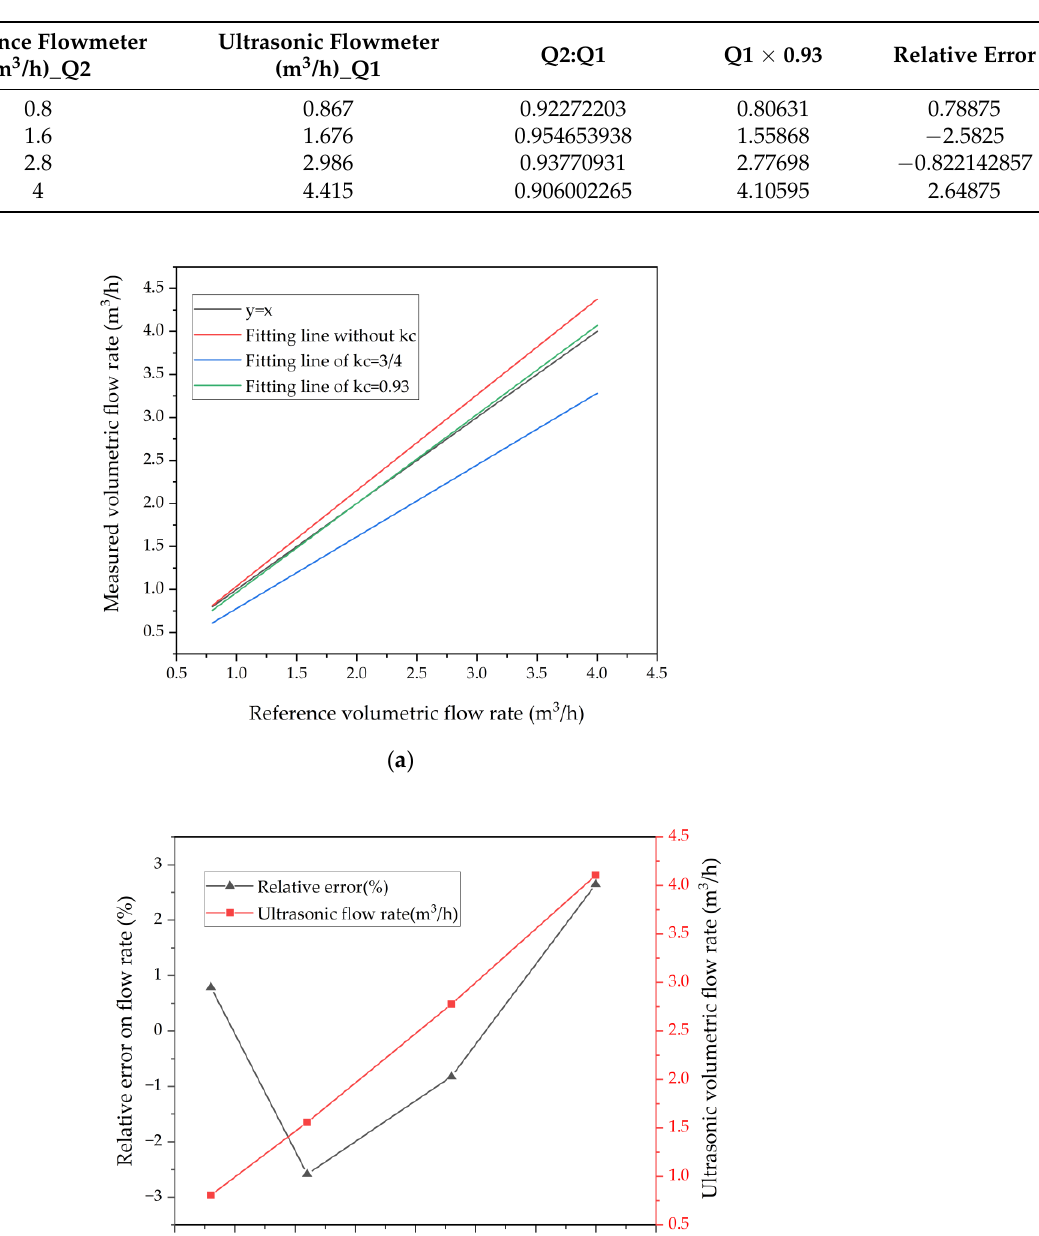
Table 2. Results of flow rate measured.